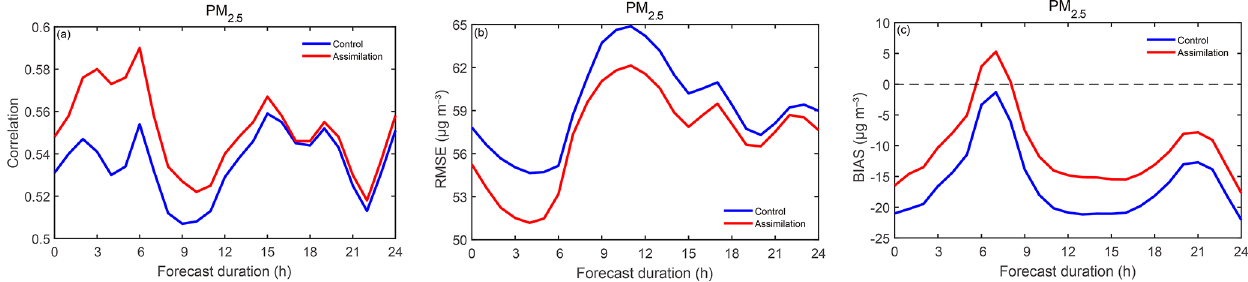
Figure 12. Statistical metrics (a) CORR, (b) RMSE, and (c) BIAS for surface PM 2 . 5 forecast performances in D02 regarding the forecast range, which are computed as an average over seven analysis steps. The blue line is the control experiment, and the red line is the assimilation experiment.